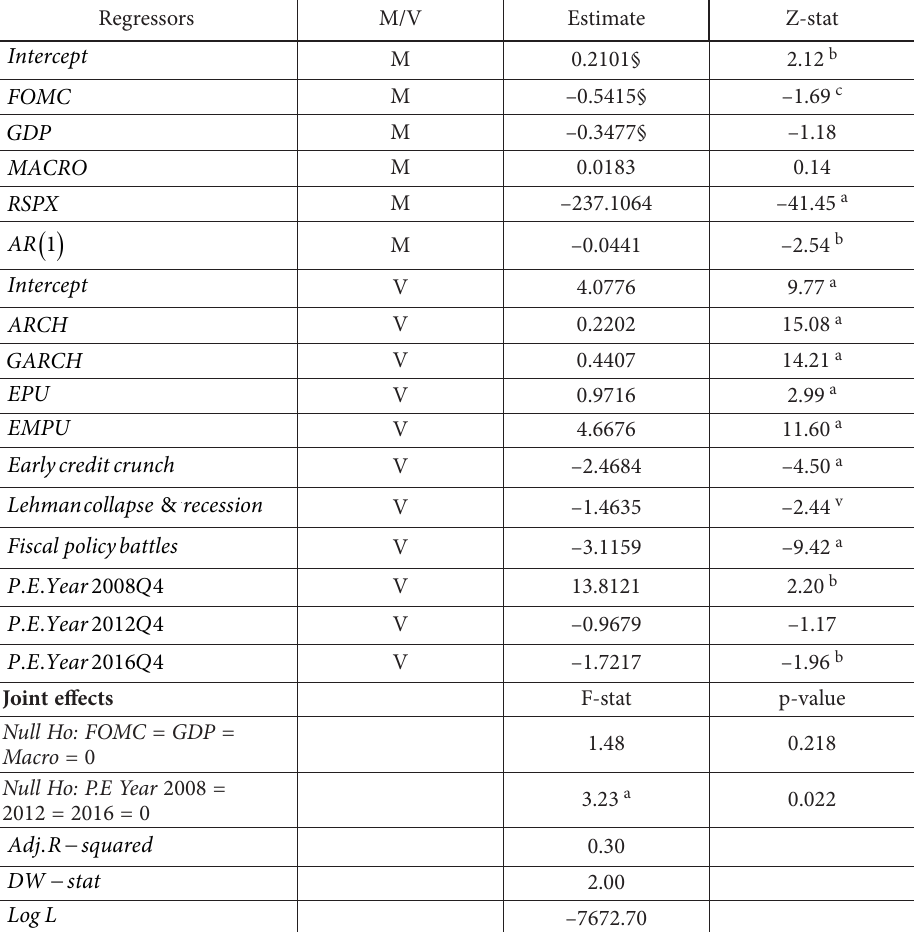
Table 8. Economic policy uncertainty and